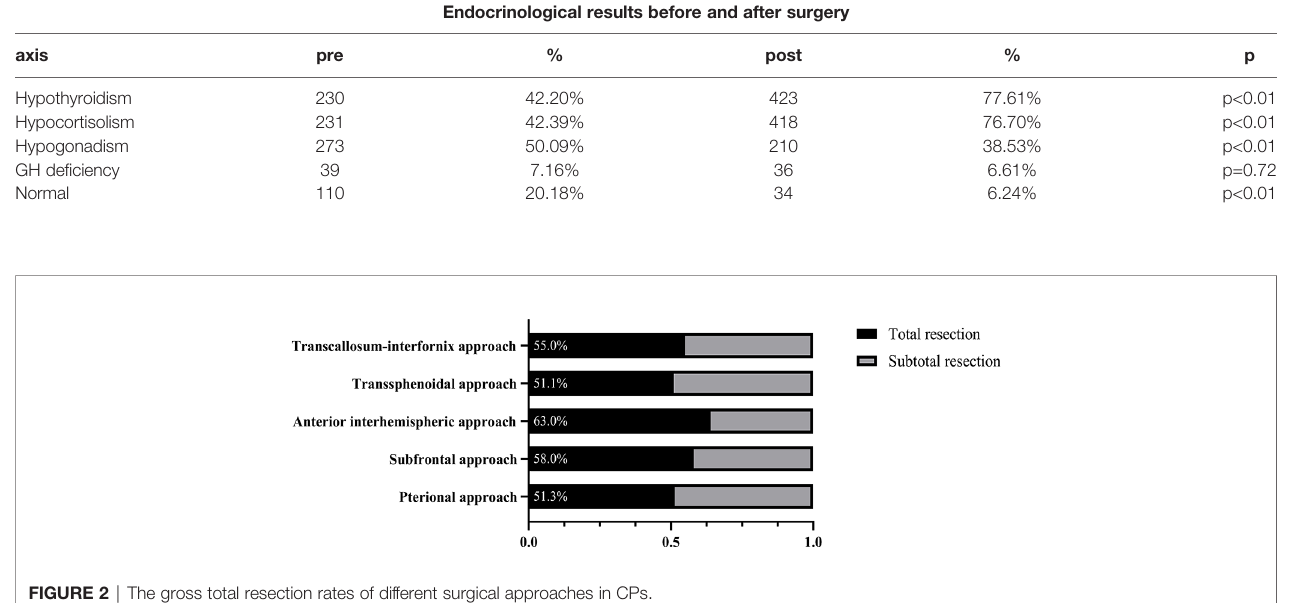
FIGURE 2 | The gross total resection rates of different surgical approaches in CPs.